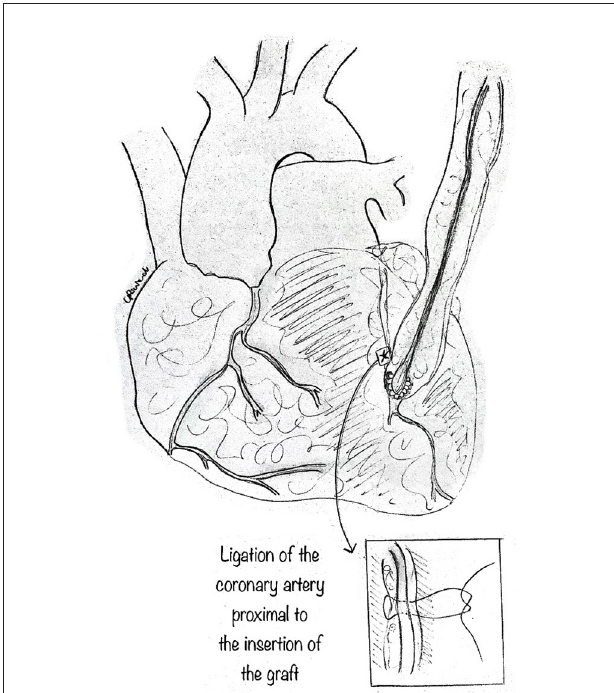
FIGURE 10 | Coronary artery bypass graft. The standard technique can be used, especially in older patients, utilizing the mammary artery as graft to the coronary. In such a case, it is imperative to ligate the coronary artery tract proximal to the insertion of the graft, so as to avoid competitive blood flow which may cause